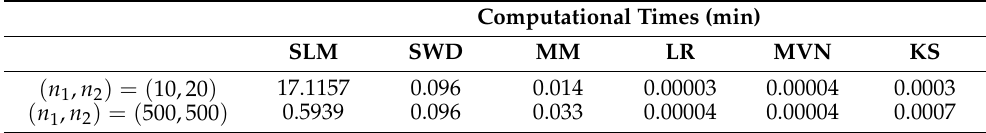
Table 17. Total computational time for each algorithm (estimated by mean of 1000 samples).